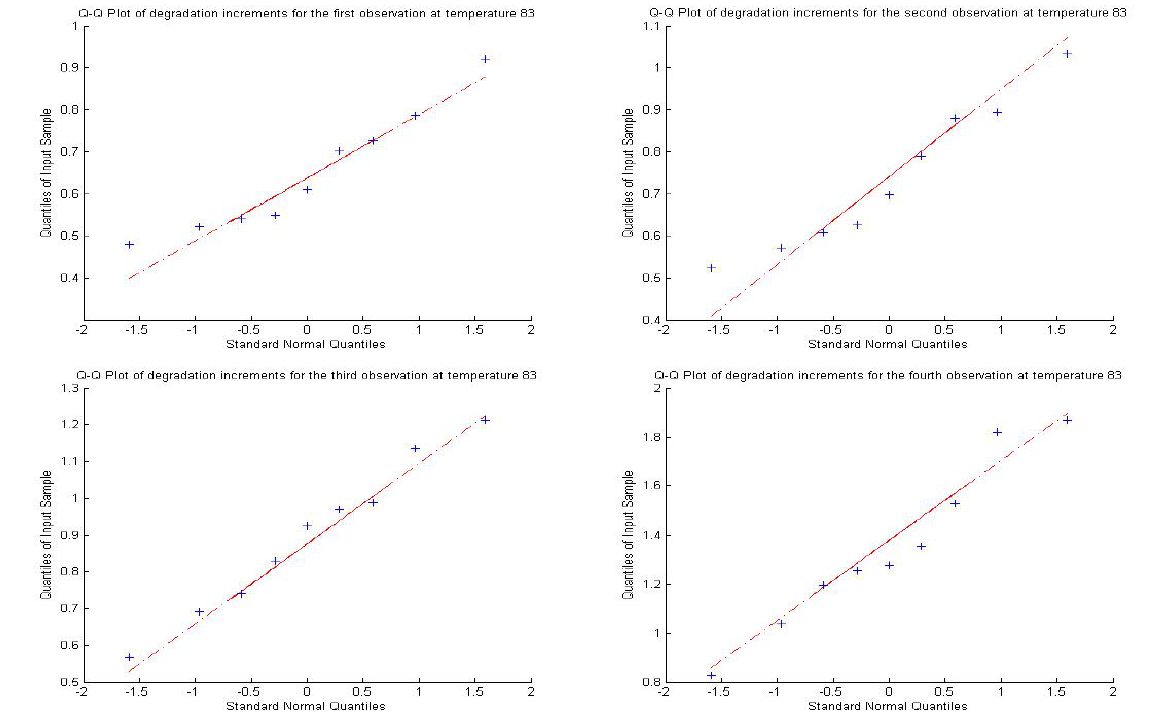
Figure 2. The Q-Q plot for degradation data at temperature 83 ◦